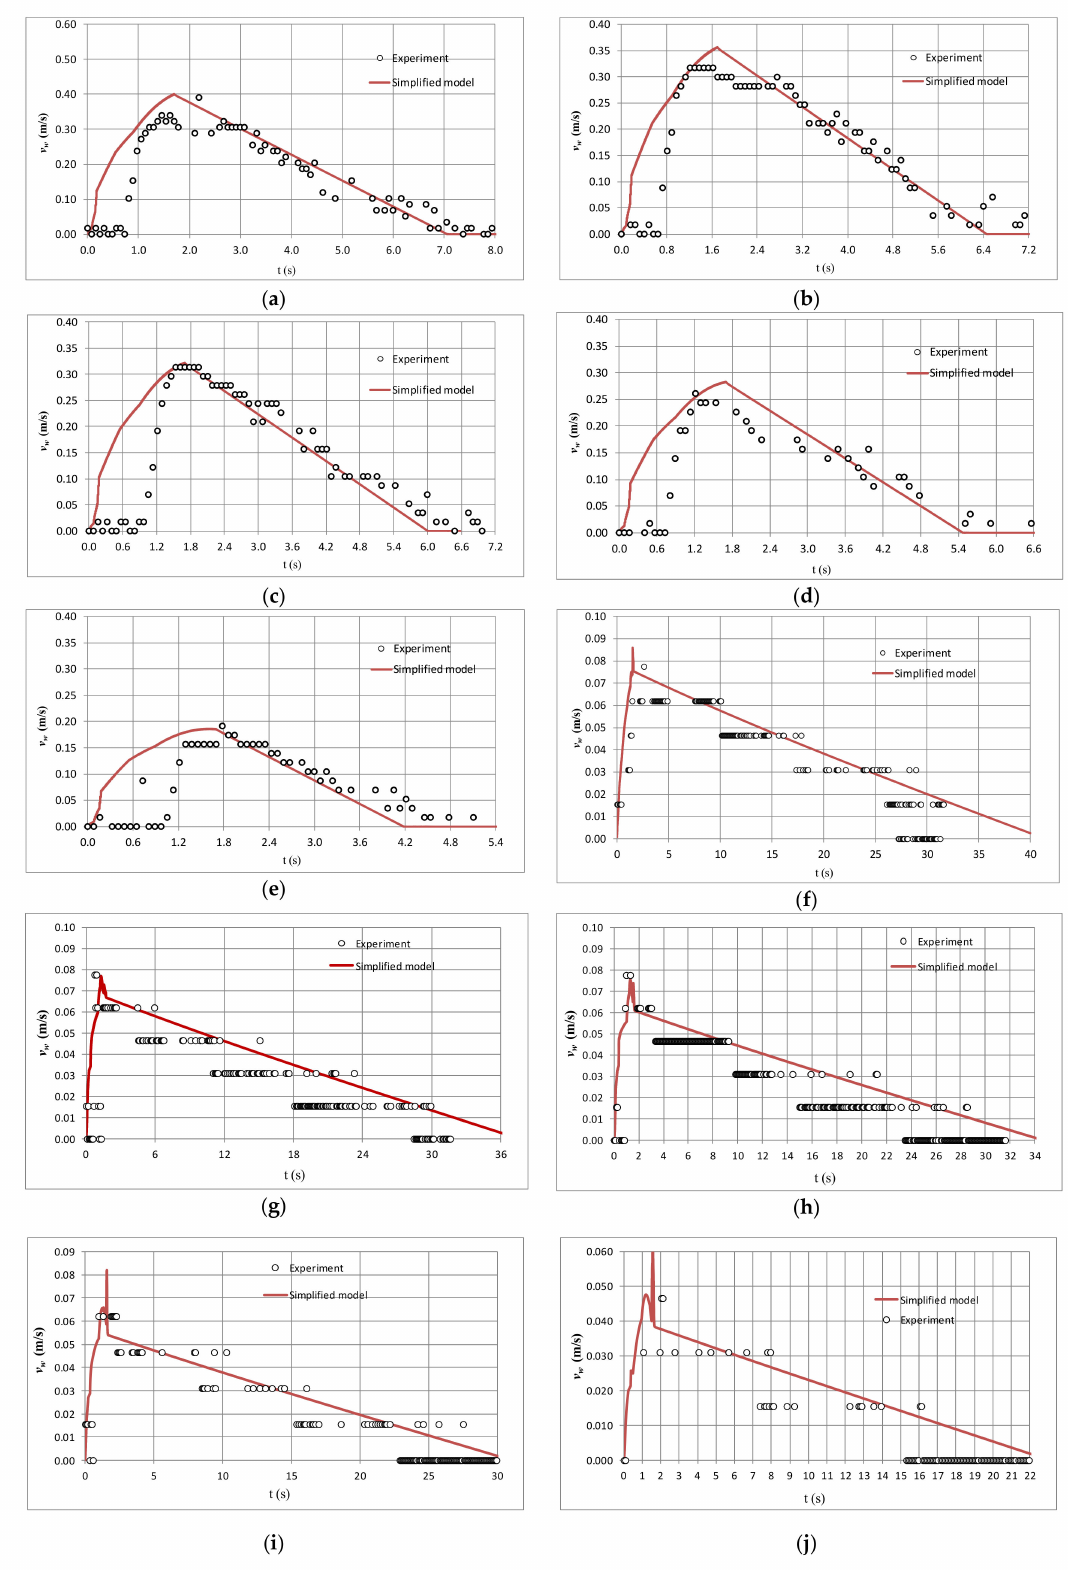
Figure 4. Comparison between measured and calculated water velocity oscillations, ( a ) Run No. 1; ( b ) Run No. 2; ( c ) Run No. 3; ( d ) Run No. 4; ( e ) Run No. 5; ( f ) Run No. 6; ( g ) Run No. 7; ( h ) Run No. 8; ( i ) Run No. 9; ( j ) Run No.